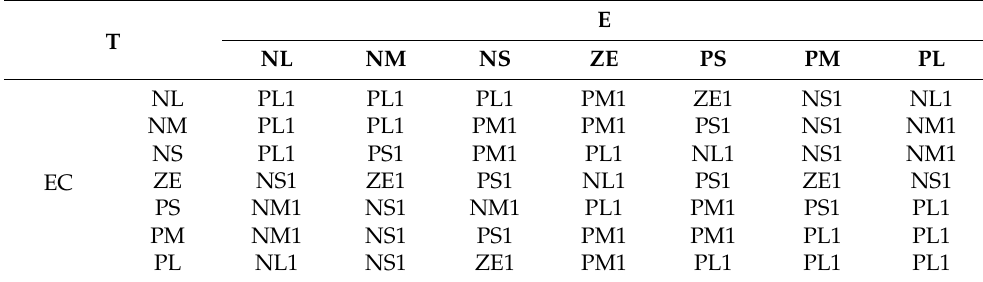
Table 3. Adjusting fuzzy rules of fuzzy